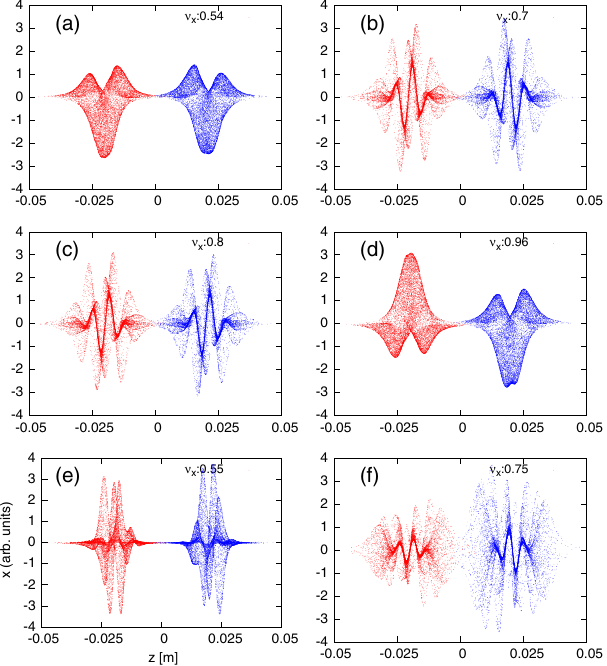
FIG. 9. Beam distribution in the x − z plane at the collision point in FCCee-Z. The horizontal tunes are (a) ν ¼ 0 . 7 , (c) ν (b) ν x N ¼ 0 . 4 N 0 , and (f) ν